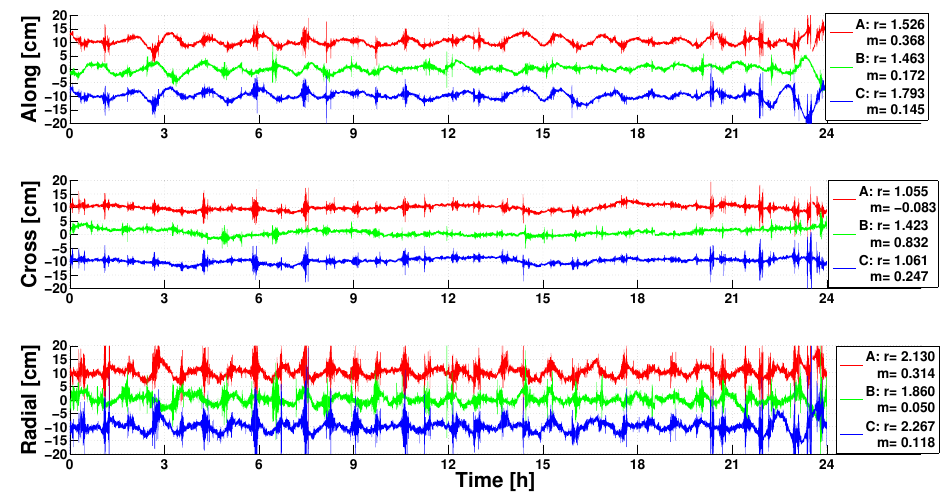
Figure 10. Position residuals for Swarm A (red), B (green) and C (blue) with respect to ESA reduced-dynamic orbits for DoY 333, 2015. The time series are offset by 10cm for Swarm A and C. The legend indicates the rms ( r ) and mean value ( m ) in